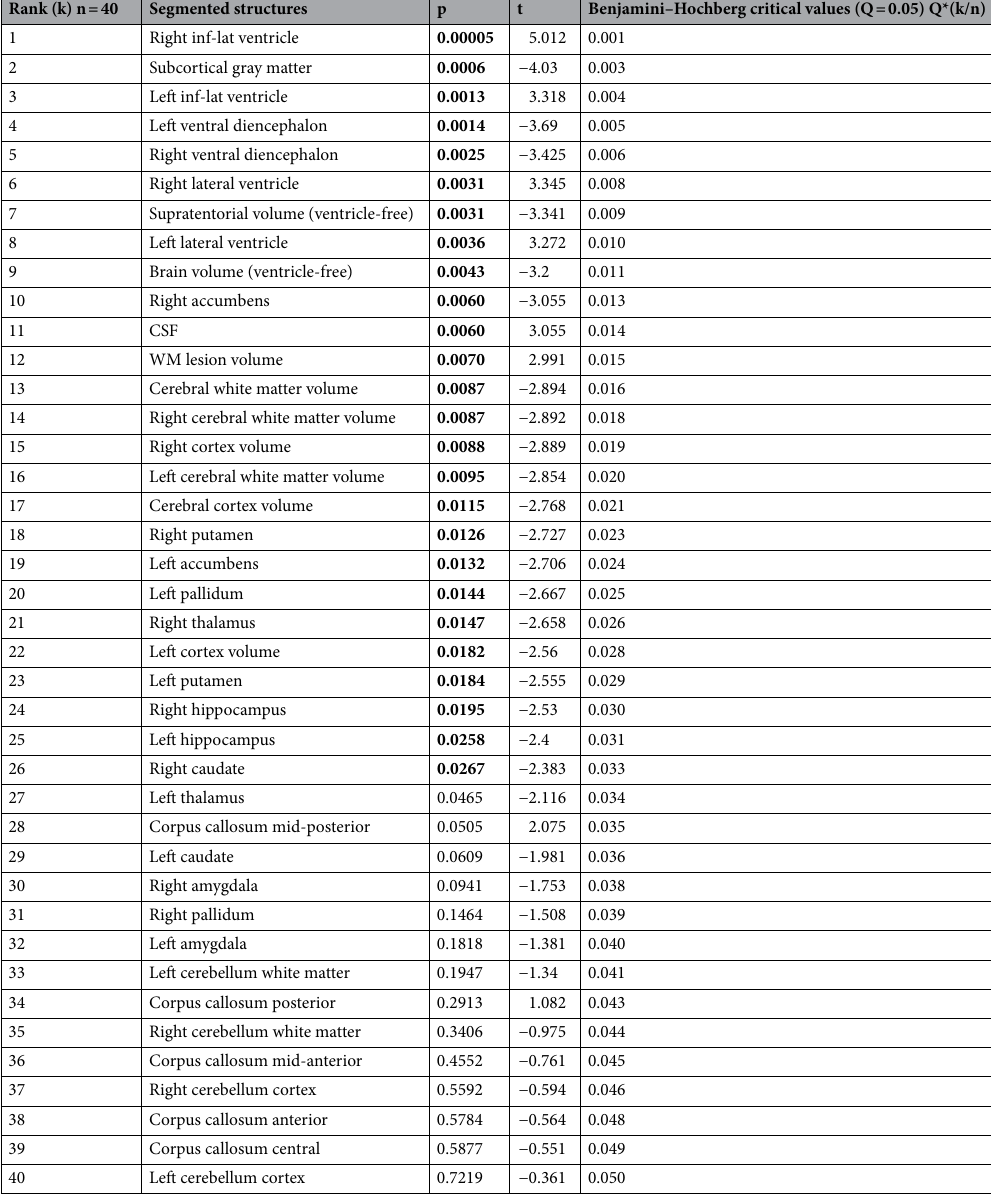
Table 2. Significant associations between OPN measured from CSF and regional brain volumes assessed 10.1 ± 2.0 years later. Table shows the results of multiple linear regression models. The dependent variables were the segmented brain structures and OPN concentration, age, gender and estimated total intracranial volume were used as independent variables. Significant p-values surviving FDR correction are presented in